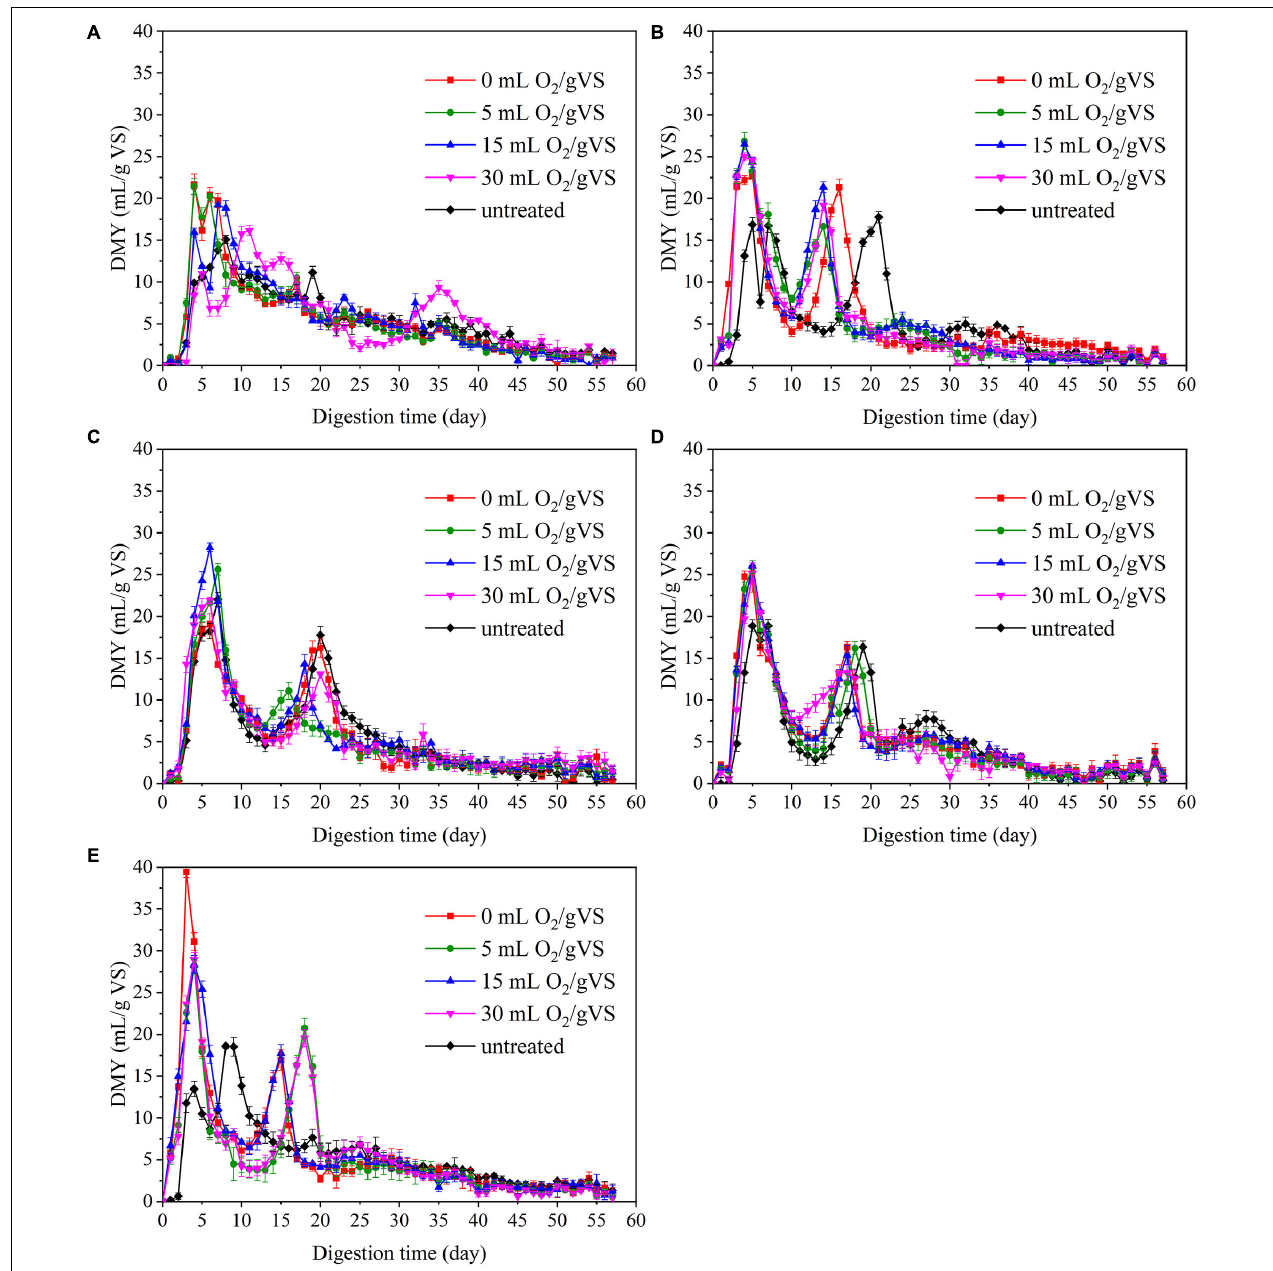
FIGURE 3 | The daily methane yield (DMY) untreated and pretreated PW by CI (A) , SI (B) , CM (C) , SM (D) , and DE (E) .